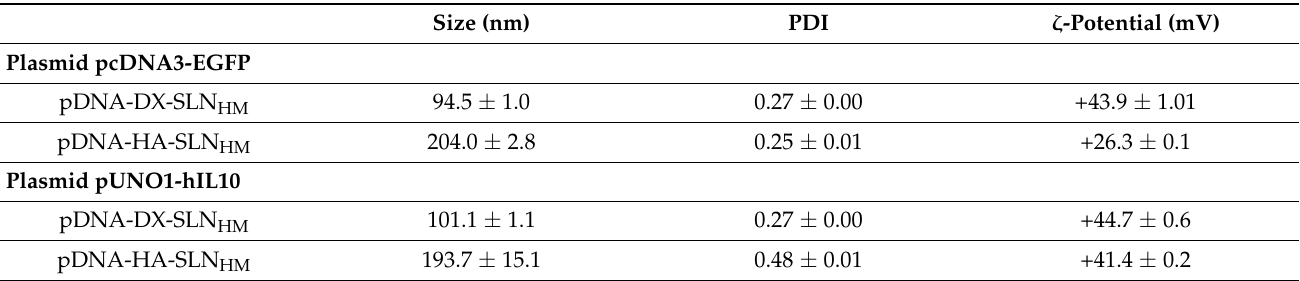
Table 4. Physical characterization of pDNA-based